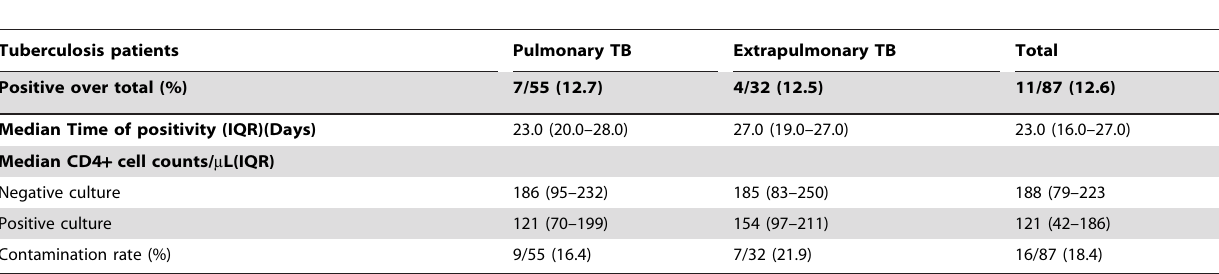
Table 15. Performances of the blood culture using the BacT/alert automated culture in the HIV-infected TB patients according to their TB